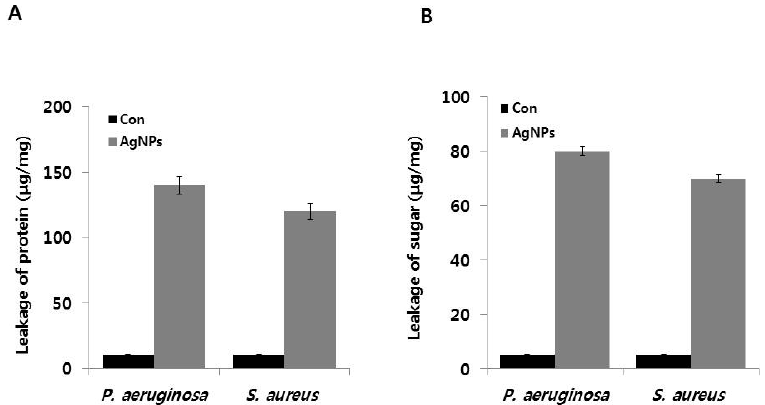
Figure 4. Effect of AgNPs on leakage of protein and sugars: ( A ) for protein leakage analysis, P. aeruginosa and S. aureus cells were treated with the respective MIC of AgNPs for 12 h, and protein levels were measured using the Bradford assay; and ( B ) for sugar analysis, all test strains were treated with respective MIC of AgNPs for 12 h, and sugar concentrations were measured. Results are expressed as the means ± SD of three separate experiments, with three replicates per experiment. Statistically significant differences between treatment and control groups were determined using student’s t -test ( p < 0.05).